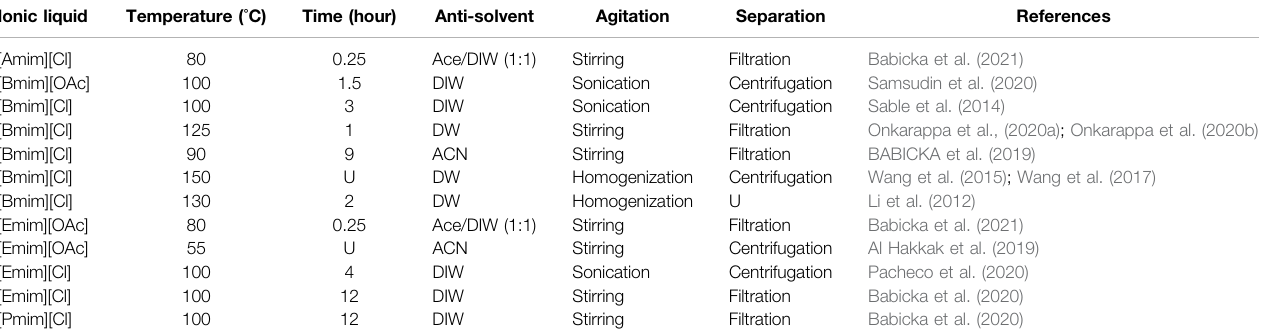
TABLE 3 | Ionic liquids, dissolution temperatures, dissolution times, anti-solvents, agitation, and separation processes are applied for the extraction of nanocellulose. Ionic liquid Temperature ( ° C)